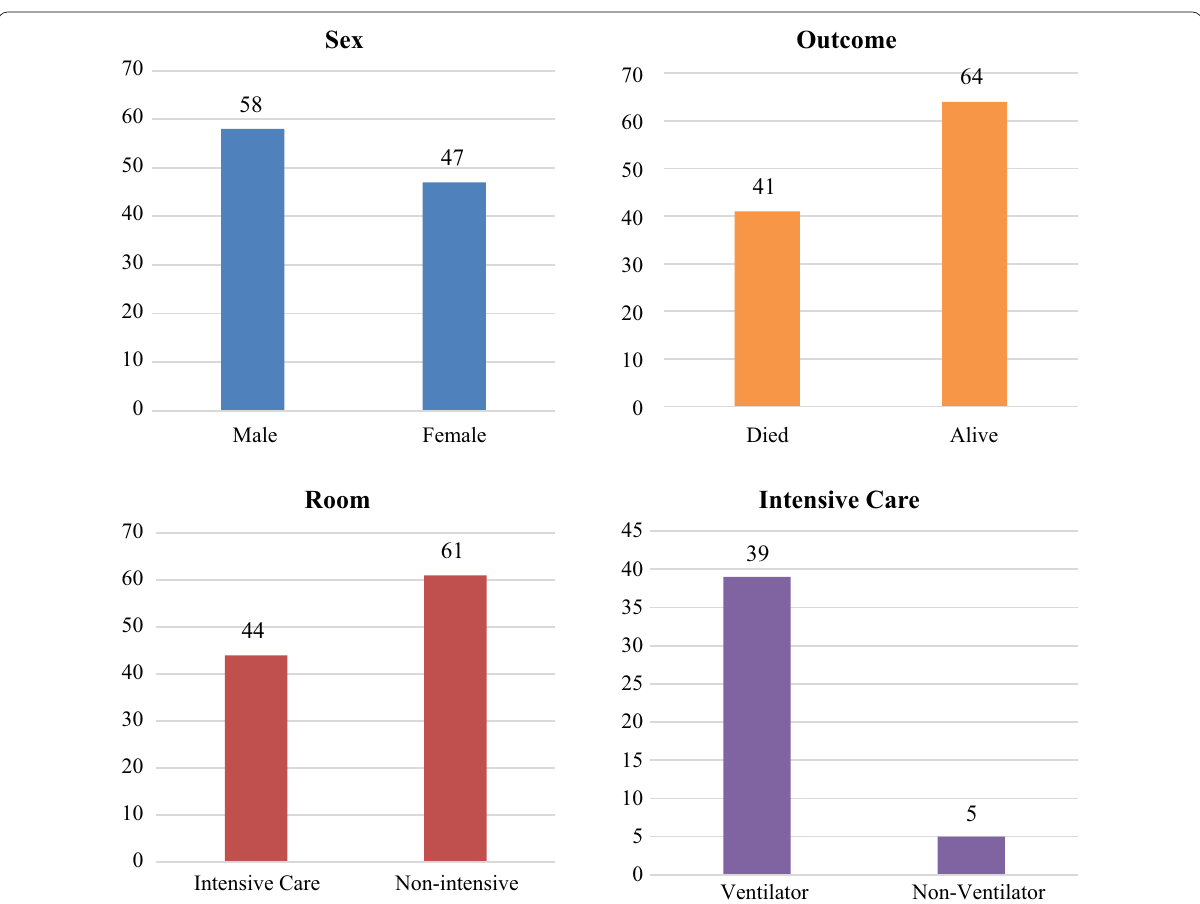
Fig. 3 Characteristic of hospitalized COVID-19 pneumonia patients. The graph shows the characteristics of COVID-19 pneumonia patients based on sex, post-treatment outcome, intensive room, and ventilator usage